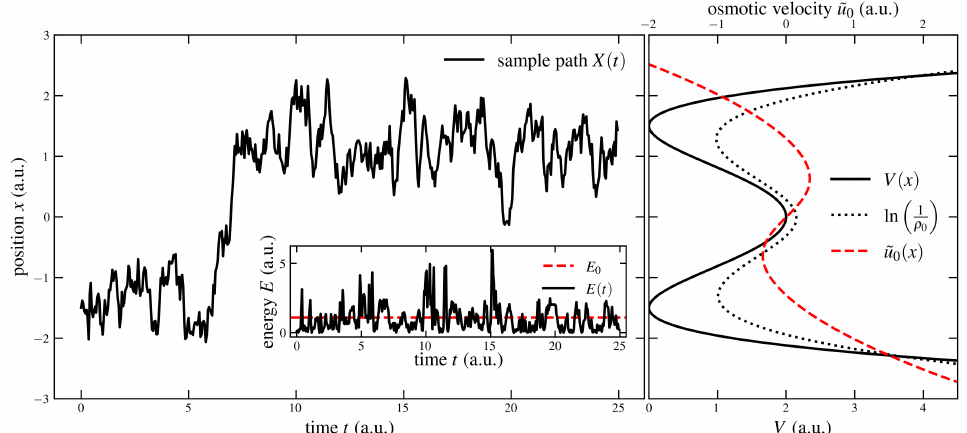
Figure 1. The left figure shows a sample path of the stochastic process X in the ground state of the double-well potential driven by fluctuations, while the inset displays its stochastic energy E ( t ) = m ˜ u 2 ( X ( t )) + V ( X ( t )) (solid black) in comparison to the mean ground state energy E 0 (dashed 2 red). The graphic on the right shows the corresponding double-well potential V ( x ) (solid black) with parameters V 0 = 2 and a = 1.5 and the osmotic velocity ˜ u 0 ( x ) (dashed red). The dotted black line depicts the ‘diffusive potential’ according to Kramers’ theory ln 1 on the ground state probability ρ 0 ( x ) of the